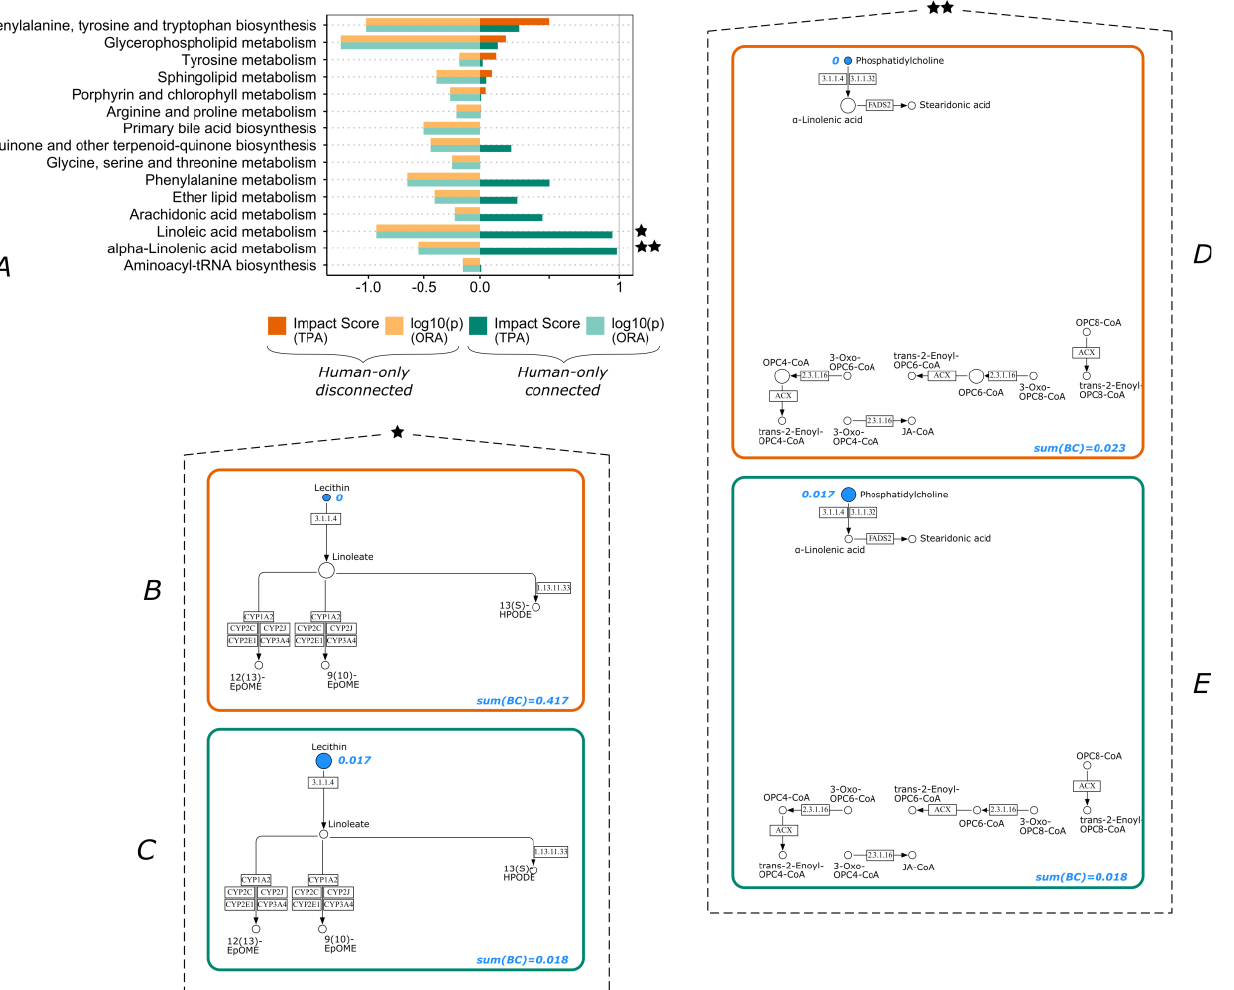
Figure 4. Pathway scoring comparison for dataset 3. ( A ) TPA impact scores and ORA log10(p) values for all pathways (pathways exhibiting zero values in all cases are omitted). ★ “Linoleic acid metabolism” pathway for ( B ) human-only disconnected and ( C ) human-only connected. ★★ “alpha-Linolenic acid metabolism” pathway for ( D ) human-only disconnected and ( E ) human-only connected. Blue color denotes significant compounds in this dataset, blue values are the computed betweenness centrality scores for these nodes, sum(BC) is the sum of betweenness centrality scores for all the nodes of the pathway, and node size corresponds to the relevant betweenness centrality scores of the nodes within the pathway.